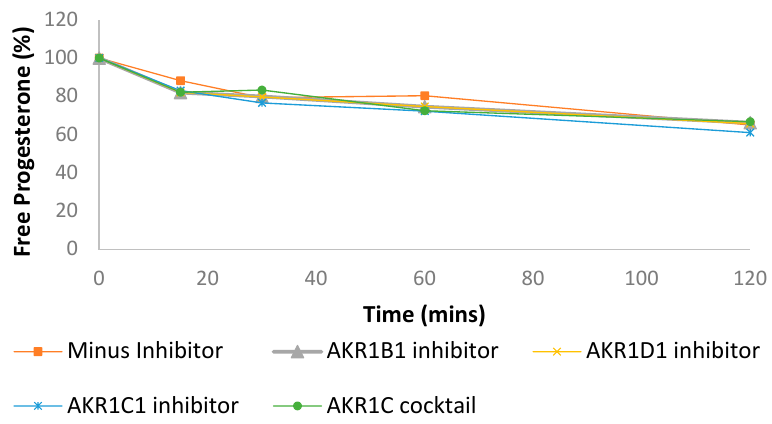
Figure A3. Concentration (expressed as percent of initial value) of progesterone as function of incubation time with human liver cytosol in absence of NADPH with the addition of AKR enzyme inhibitors, as indicated.